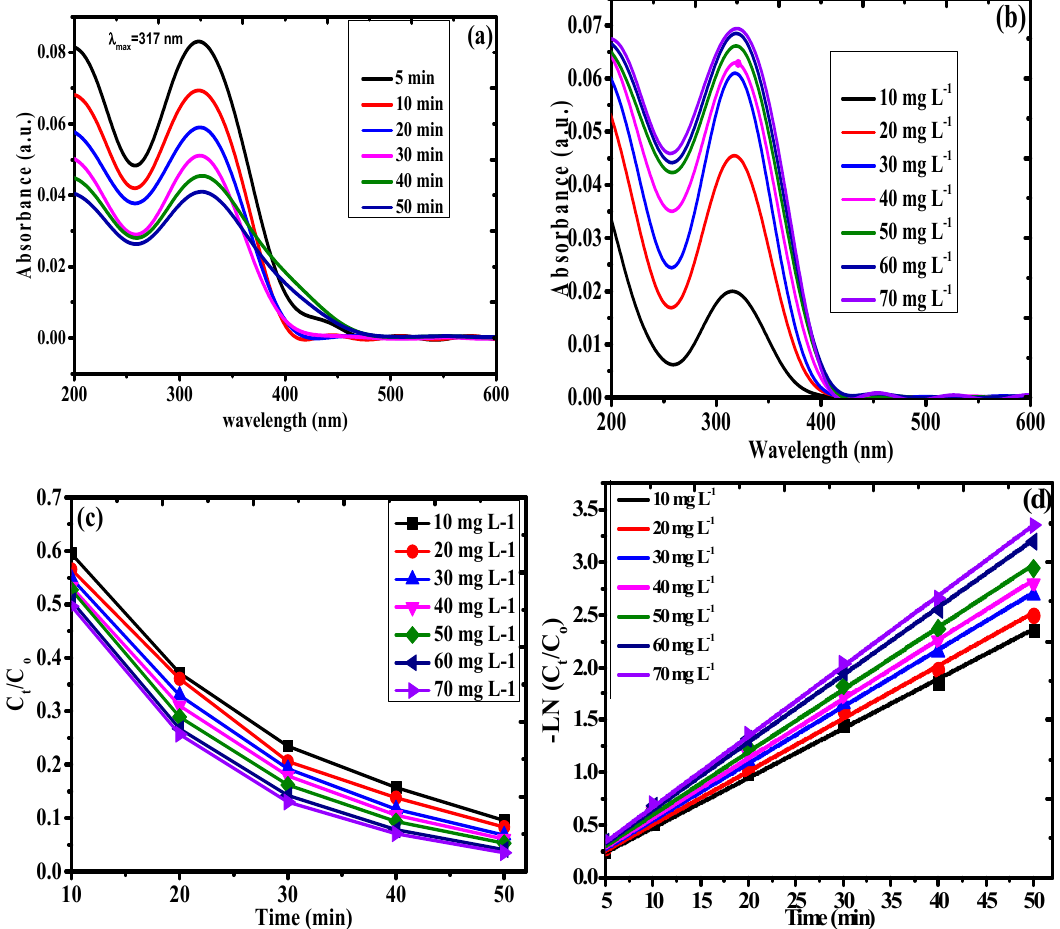
Figure 8. ( a ) UV–Vis action curve for irradiation time; ( b ) UV–Vis action curve for variable concentration of DNP; ( c ) Ce / Co vs. irradiation curve; and ( d ) pseudo-first order kinetic ci = curve for variable concentration of DNP. Table 4. Pseudo-first-order kinetic model for the photodegradation of DNP by PAN-g-Alg@Ag NC with the associated error analysis.